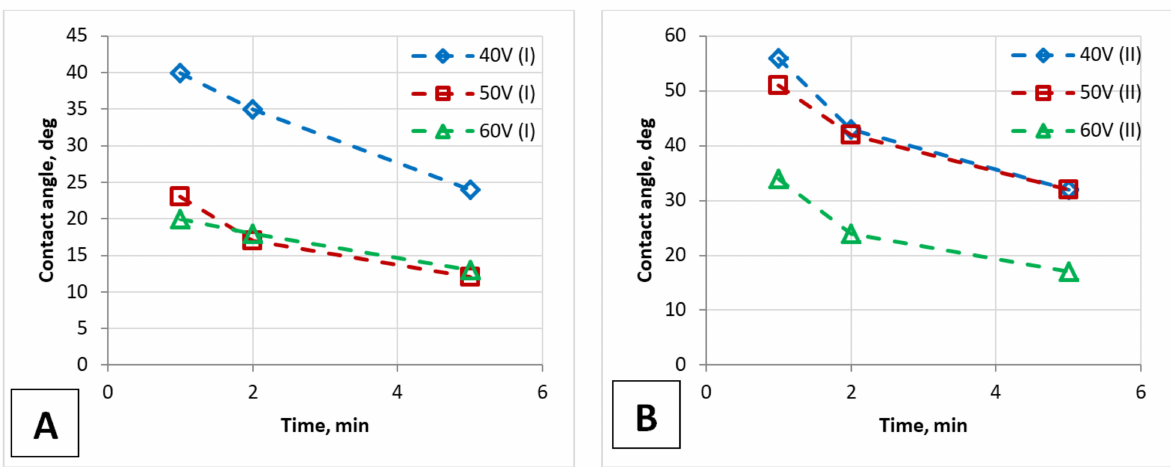
Figure 12. Demonstration of a PAA film’s surface wetting ability (contact angle): the graph for contact angles during the applying of a water drop on the PAA surfaces of the one-stage ( A ) and two-stage ( B ) anodized